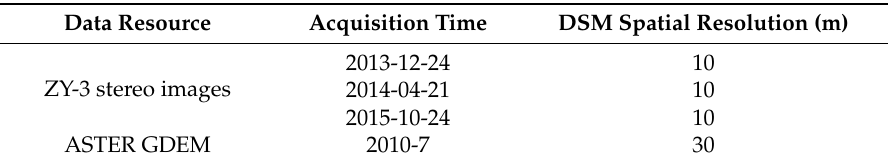
Table 1. Datasets used in this study.